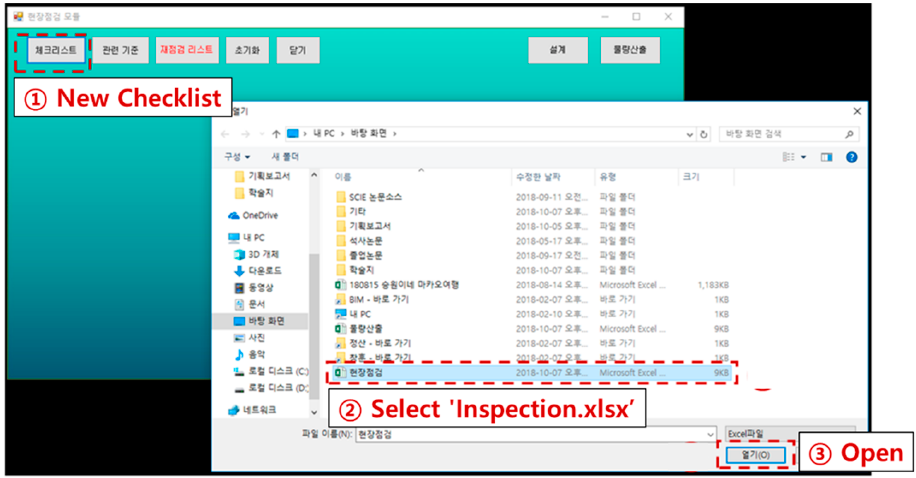
Figure 13. Quality inspection module—automated creation of the checklist.